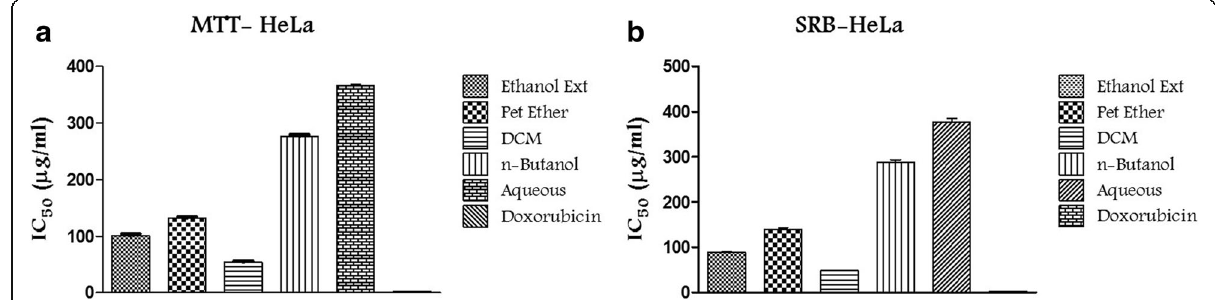
Fig. 3 In vitro MTT and SRB assays on HeLa cells. HeLa cells were incubated with different concentrations (25, 50, 100, 200 μ g/mL) of ethanol extract and its fractions of T cordifolia ; Growth inhibition was determined by the MTT and SRB assays. IC 50 values were calculated by mean